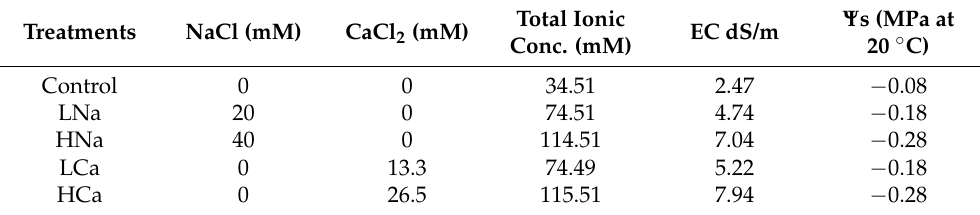
Table 5. Addition of different salts (mM) to a basic nutrient solution (control) aiming to establishing four salinity treatments (referred to as low and high salinity level) and the salinity source. Control: standard nutrient solution ( − 0.08 MPa, 20 ◦ C); LNa: low NaCl-salinity ( − 0.18 MPa, 20 ◦ C); HNa: high NaCl-salinity ( − 0.28 MPa, 20 ◦ C); LCa: low CaCl 2 -salinity ( − 0.018 Mpa, 20 ◦ C); HCa: high CaCl 2 -salinity ( − 0.28 MPa, 20 ◦